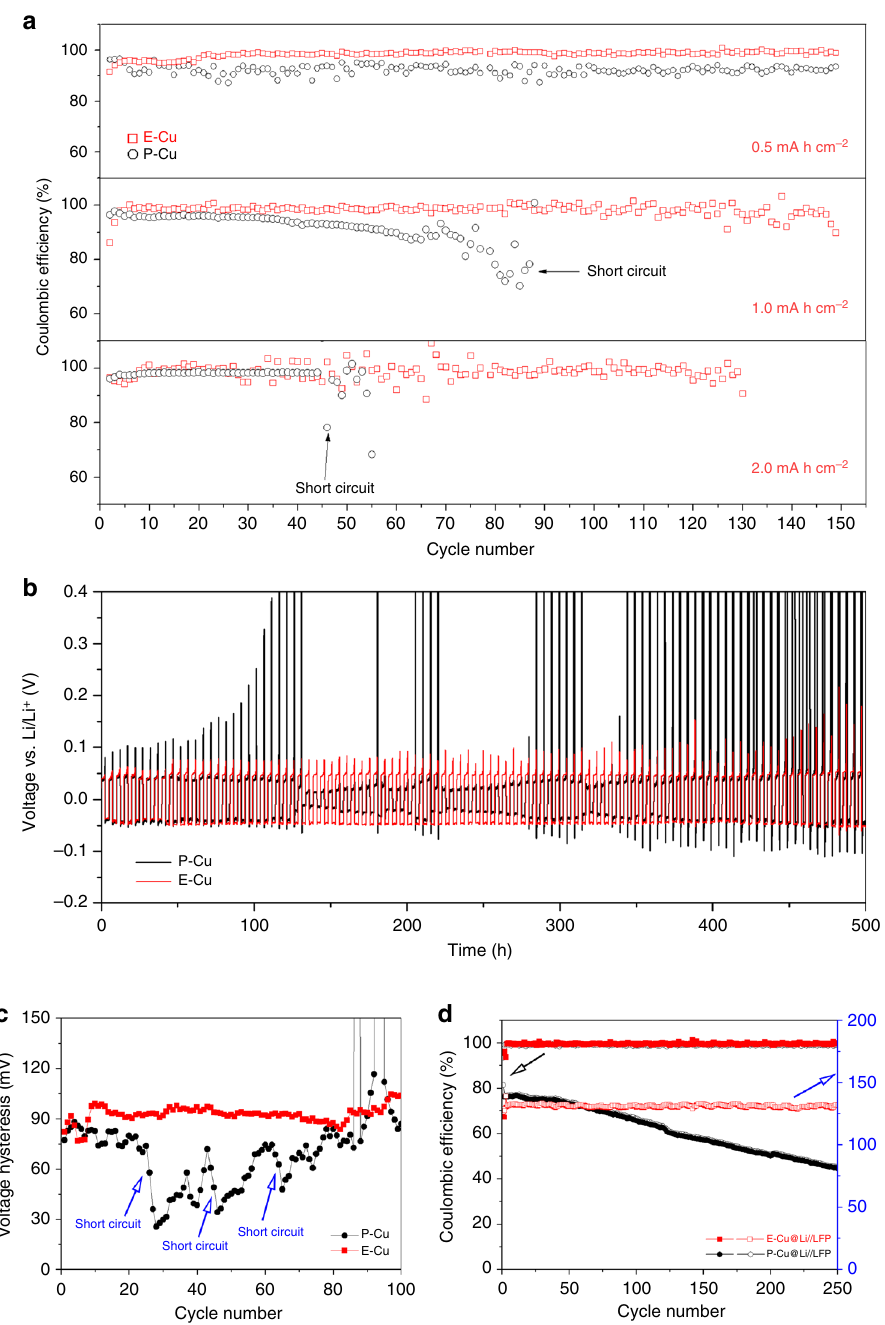
Fig. 6 Electrochemical performance of Li metal anodes. a Comparison of cycling performances (Coulombic ef fi ciency) of the P-Cu- and E-Cu-based Li metal anodes at 0.5 mA cm − 2 with varied amounts of plating/stripping Li metal. b Voltage-time pro fi les and c average voltage hysteresis of Li metal anodes in Cu@Li//Li systems based on E-Cu and P-Cu with a plating/stripping capacity of 0.5 mA h cm − 2 at 0.2 mA cm − 2 . In this case, 2 mA h cm − 2 of Li was plated at 0.2 mA cm − 2 in two current collectors. d Cycling performances of the Cu@Li//LiFePO 4 battery systems using Li metal anodes with E-Cu and P-Cu at